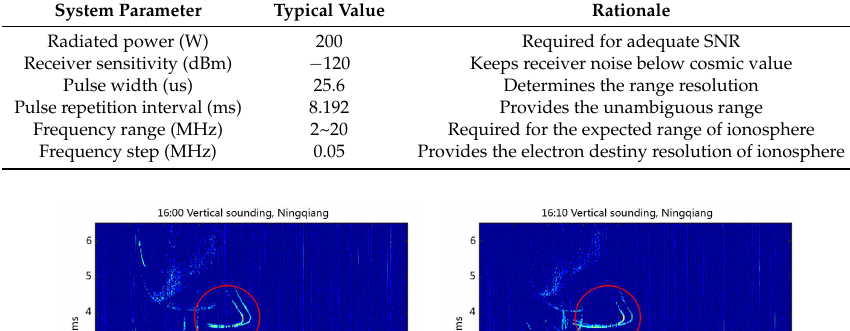
Table 2. Sidelobe peak level of ambiguity function with Doppler shift.